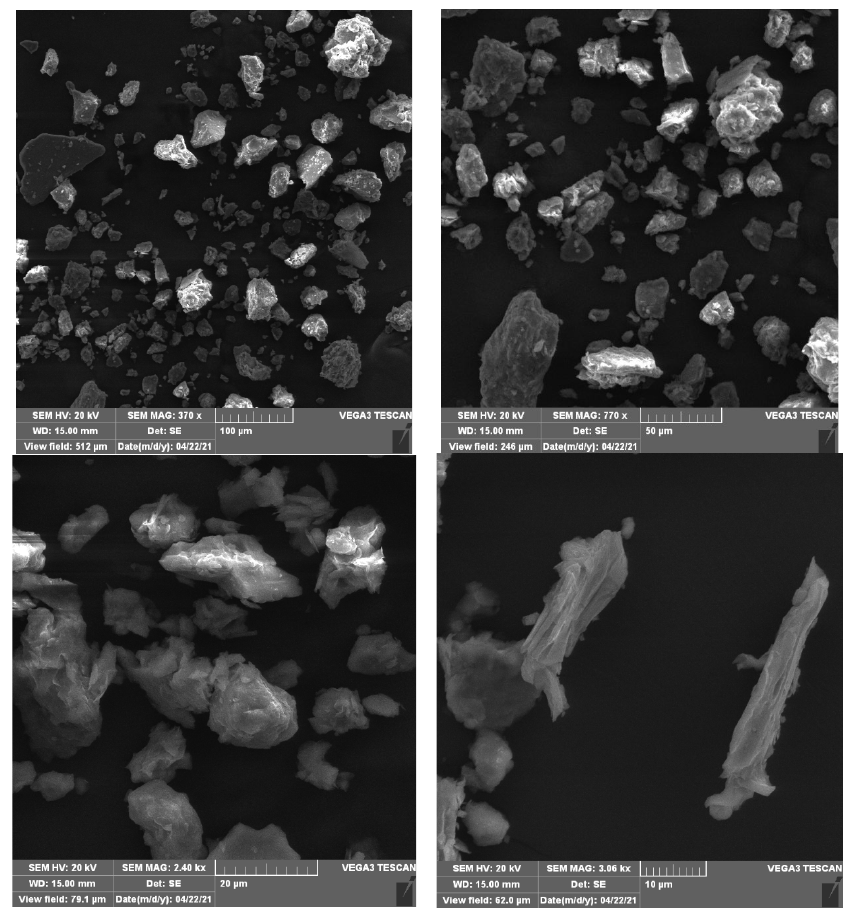
Figure 2. Brari clay images analyzed by scanning electron microscope (SEM) with resolutions of 100 µm, 50 m, 20 µm, and 10 µm.